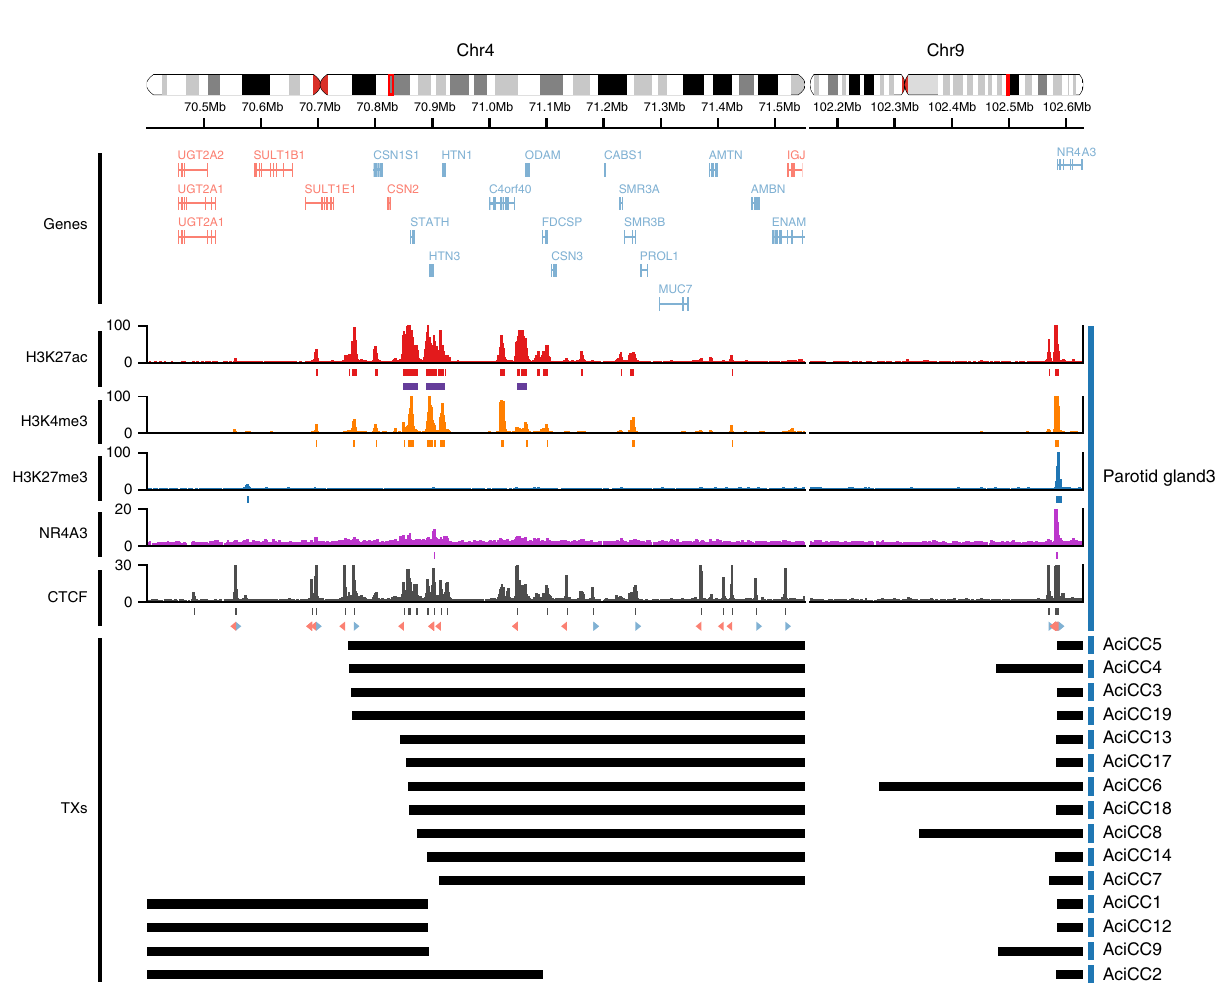
Fig. 3 Detailed characterization of rearrangements t(4;9)(q13;q31) in 15 AciCCs identify three different breakpoint patterns. Detailed presentation of rearrangements in 15 AciCCs with t(4;9)(q13;q31), with black bars indicating genomic material included in the rearrangement. Active (H3K27ac, H3K4me3) and repressive (H3K27me3) histone marks, NR4A3 binding sites and CTCF binding sites in normal parotid gland tissue are presented for comparison. Source data for translocation breakpoints are provided as a Source Data fi reduced H3K27ac peaks, there were only few reduced NR4A3 peaks NR4A3 target genes CCND1 13 and ENO3 14 were higher expressed in the tumor tissues, and only 2% of the downregulated genes were in AciCC tissues on the mRNA level compared to normal parotid associated with reduced NR4A3 peaks. Motif analysis of differential gland tissue (Supplementary Figure 4), and this was con fi rmed on H3K27ac peaks in the three tumors vs. the normal parotid tissue the protein level by immunohistochemistry (Supplementary identi fi ed a signi fi cant enrichment of the NGFI-B response element Figure 5, Supplementary Table 2). (NBRE) (Fig. 6b), which is the main binding motif for NR4A family members 12 . Correspondingly, de-novo motif analysis of enriched Functional effects of NR4A3 overexpression in vitro . To NR4A3 peaks in ChIP-seq data from three AciCC tumor samples demonstrate the driver activity of NR4A3 in cellular systems, we revealed the same motif in all three cases (Fig. 6b). The known stably transduced immortalized primary mouse submandibular